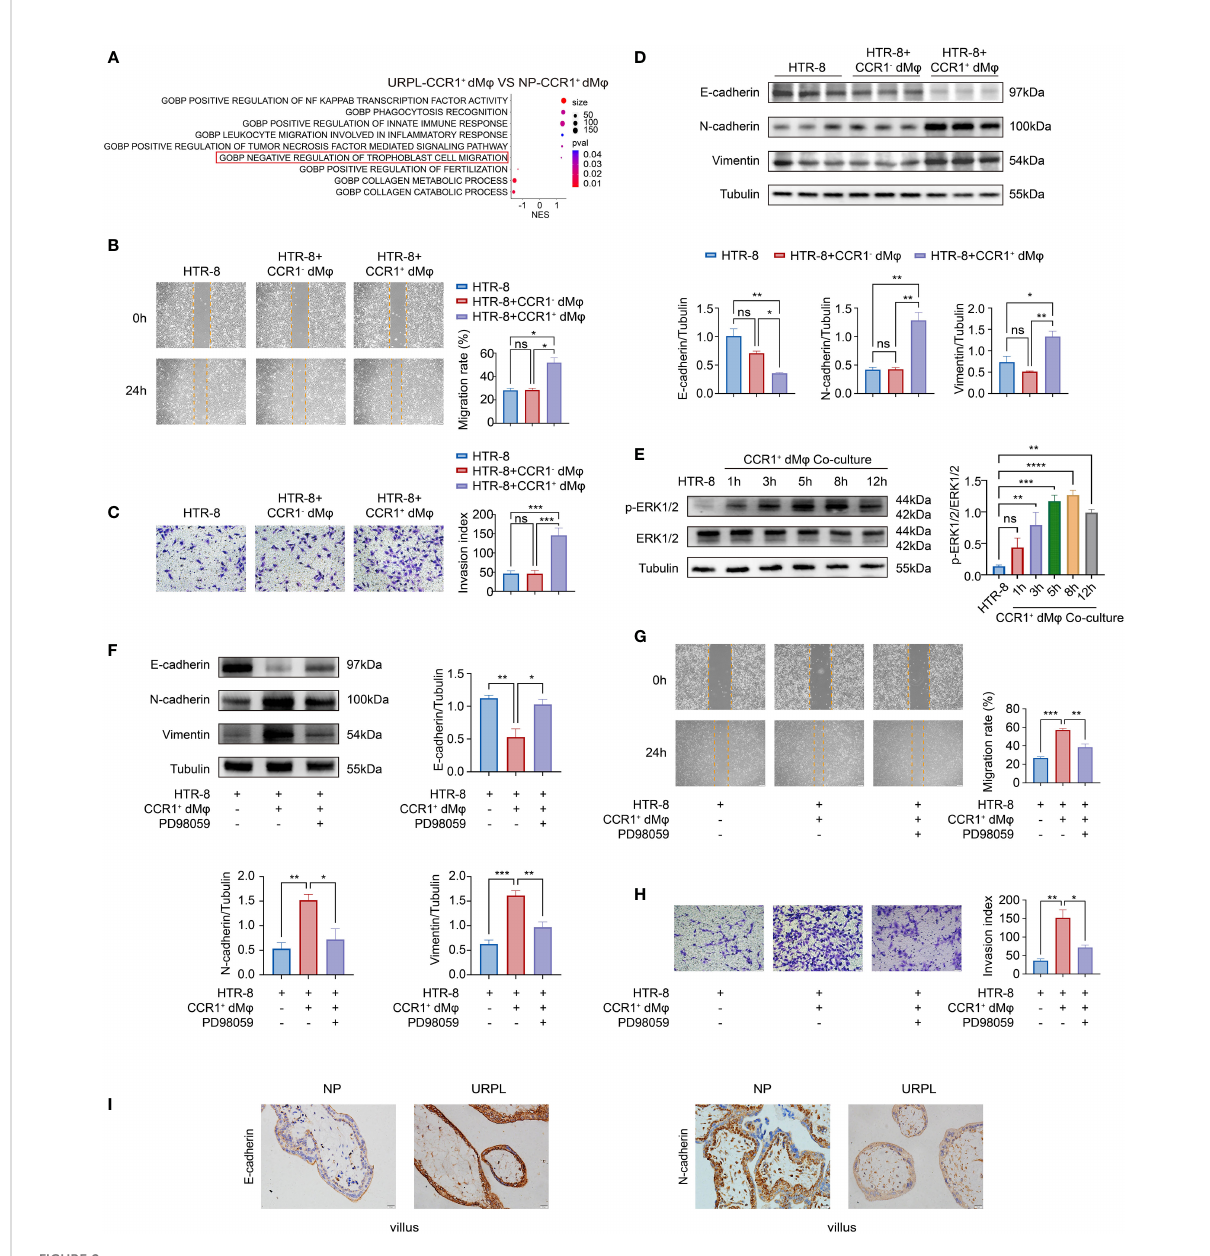
FIGURE 2 CCR1 + dM j promote the migration, invasion, and EMT process of trophoblast cells. (A) Selected GO pathways of the DEGs of CCR1 + dM j in NPs and URPL. (B – D) HTR-8 cells were co-cultured with CCR1 - dM j or CCR1 + dM j . (B) Scratch wound healing assay and quantitation were established to determine the migratory properties of trophoblast cells. 5 samples from two independent experiments. (C) Matrigel invasion assay and quantitation were performed to analyze the invasive capacity of trophoblast cells. 5 samples from two independent experiments. (D) Whole lysates of trophoblast cells were detected for the expression of EMT markers (n=3/group, 2 repeated experiments). (E) WB analysis showing the alternation of ERK1/2 pathways in HTR-8 cells co-cultured with CCR1 + dM j . Images are representative of 3 samples from 3 independent experiments. (F – H) HTR-8 cells were pretreated with an ERK1/2 inhibitor (PD98059) before co-culture with CCR1 + dM j . (F) Immunoblots showing the expression of E-cadherin, N-cadherin, and vimentin in HTR-8 cells treated as indicated. Images are representative of 3 samples from 3 independent experiments. (G) Scratch wound healing assay and (H) invasion assay were performed in HTR-8 cells treated as indicated. 5 samples from two independent experiments. (I) Representative immunohistochemical staining images showing the expression of EMT markers in human villous tissues from women with NPs (n=3) and URPL (n=3). The results were representative of three separate experiments. Data are presented as mean ± SEM. ns, not signi fi cant; *p < 0.05, **p < 0.01, ***p <